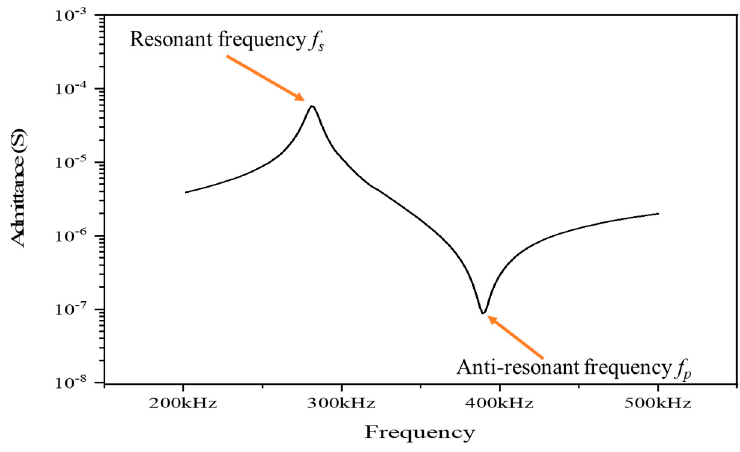
Figure 3. Admittance curve of the novel composite (v s = 0.6, v c = 0.4).